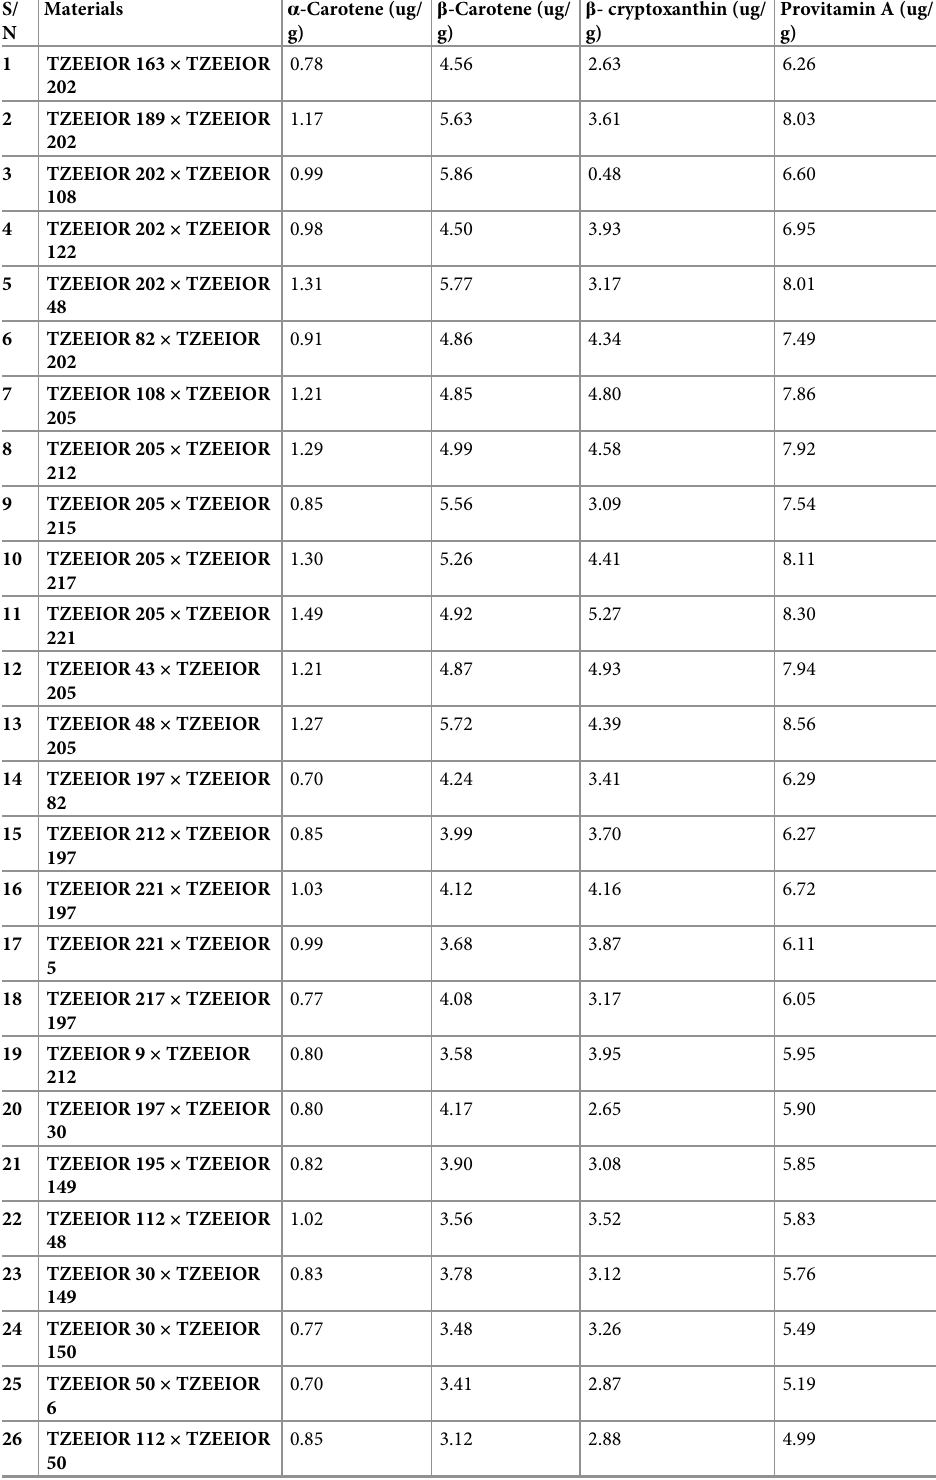
Table 9. The PVA contents of selected extra-early single-cross